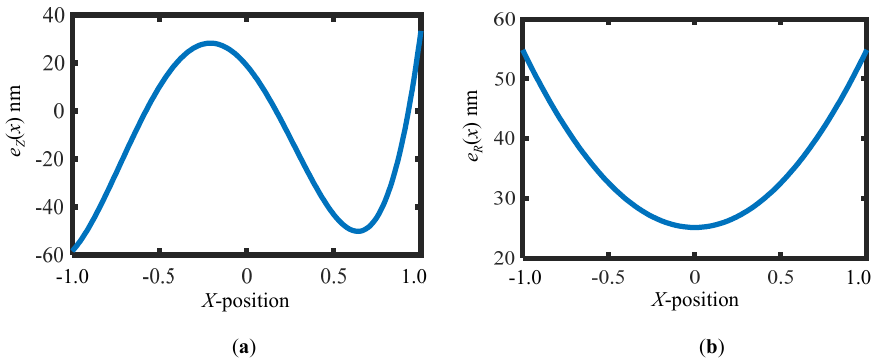
Figure 5. Simulated form of the VLS grating and the reference flat: ( a ) Simulated out-of-flatness of the VLS grating; ( b ) Simulated out-of-flatness of the reference flat.